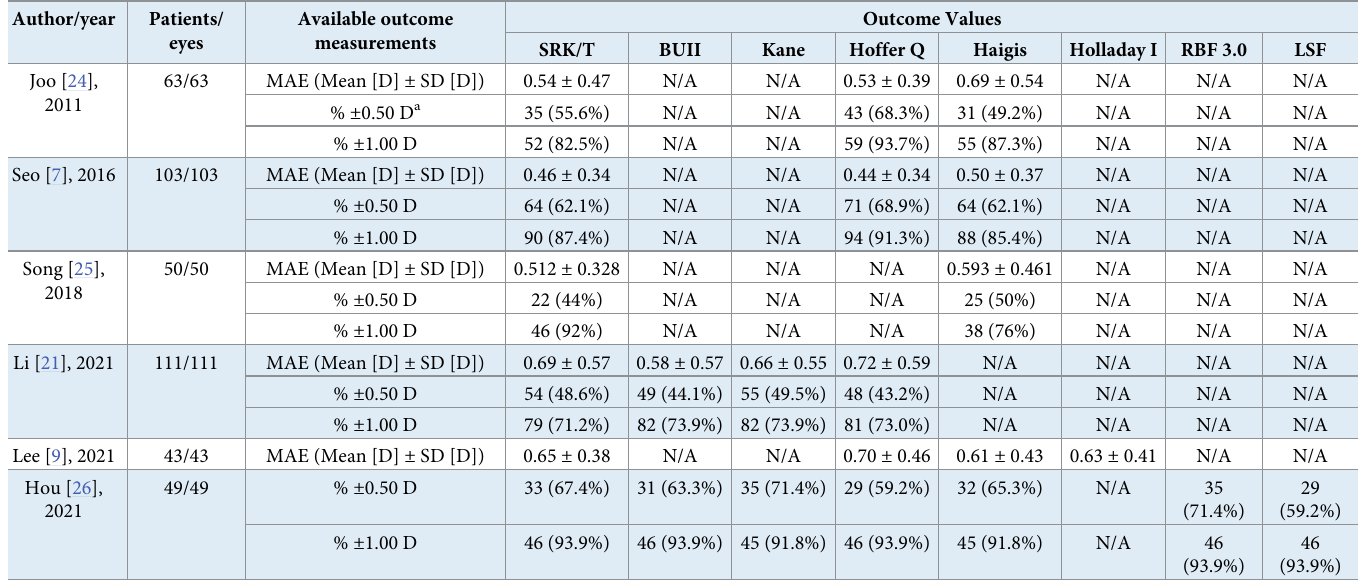
Table 2. Outcome values for quantitative analysis of enrolled studies.